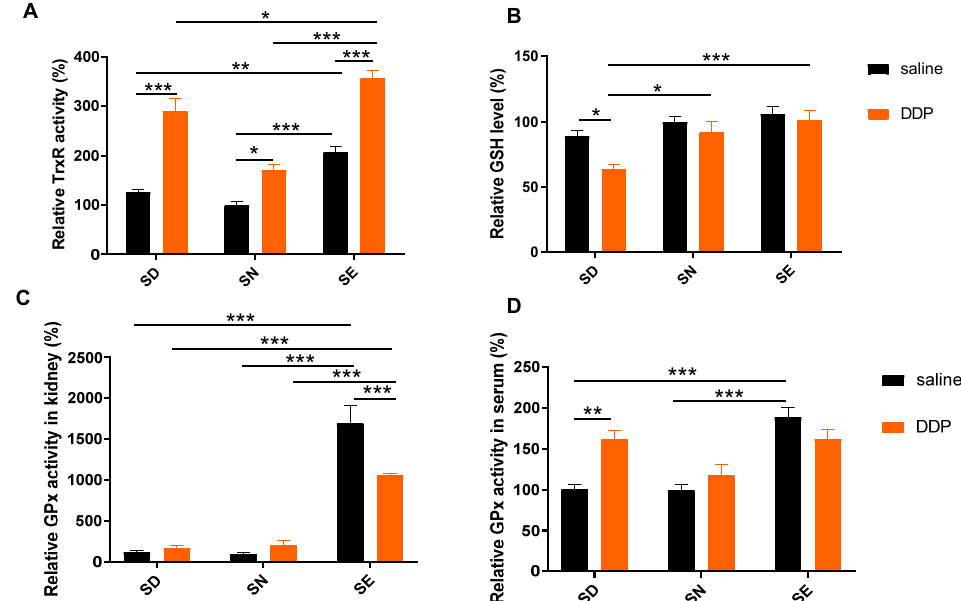
Figure 3. Selenium status affects TrxR and GPx activity and GSH levels in kidney after DDP treatment. ( A ) Total TrxR activity and ( B ) GSH levels in kidney were measured using the DTNB assay. Total GPx activity in kidney ( C ) and serum ( D ) were measured using H 2 O 2 as a substrate to detect. Each sample was analyzed in triplicate. Data are normalized using the value from samples of SN saline group as control (100%) and presented as mean ± SEM; * p < 0.05; ** p < 0.01; *** p < 0.001; two-way ANOVA, n = 5–6. SD, selenium-deficient; SN, selenium-normal; SE, selenium-enriched; DDP, cisplatin.